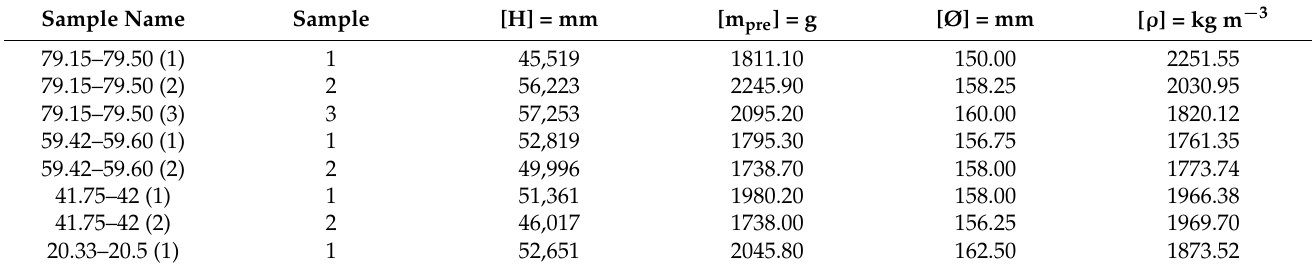
Table 2. HFM sample dimensions and mass properties from the drill cores at different depths.